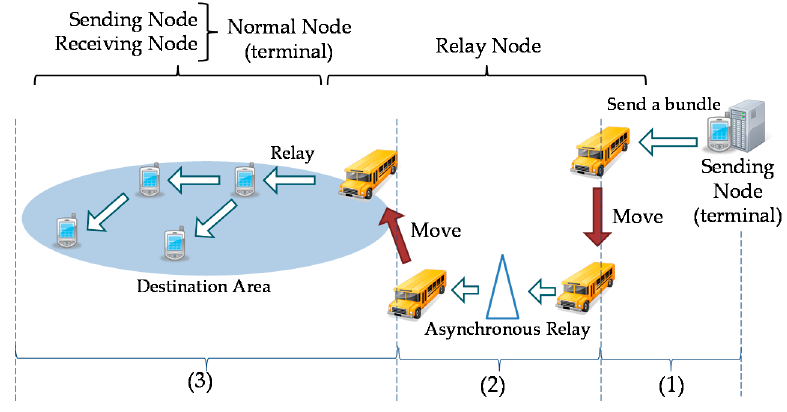
Figure 10. Bundle relay sections between the sending node and the receiving node.